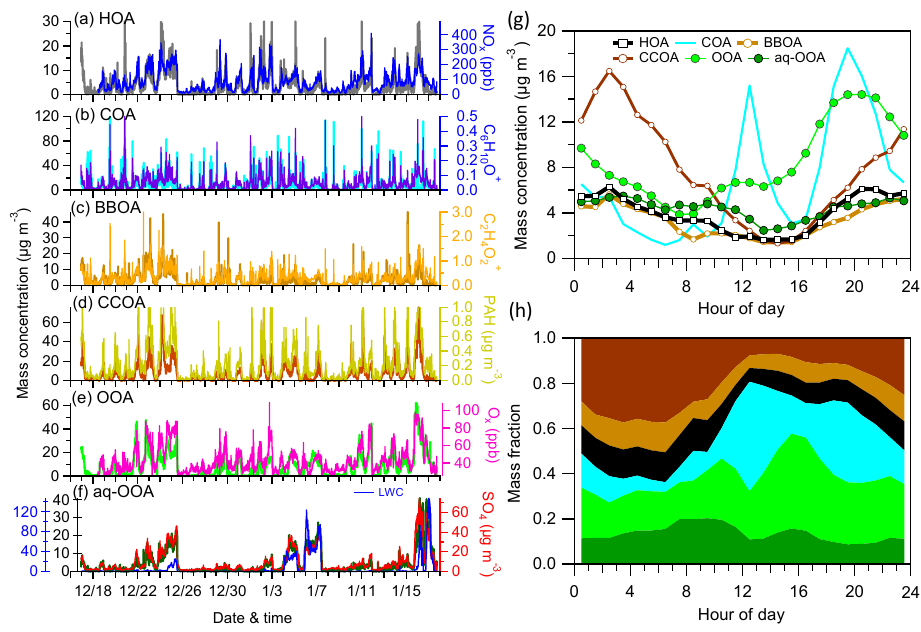
Figure 9. Time series of six OA factors and average diurnal cycles of mass concentrations and mass fractions of OA factors. The external tracer species, including NO x , C 6 H 10 O + , C 2 H 4 O + , PAH, O x and SO 4 , are also shown for comparison. 2